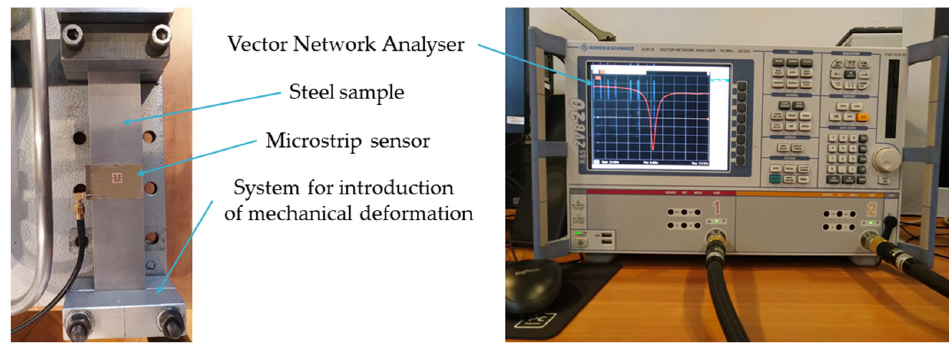
Figure 4. Photo of the measuring system.